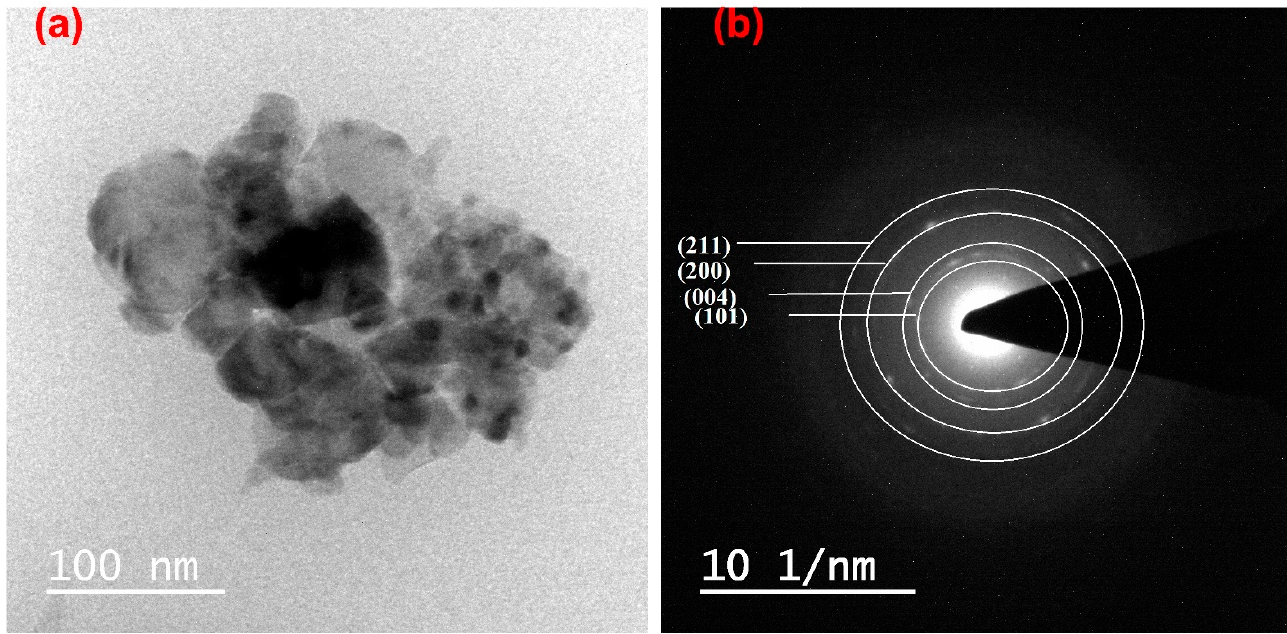
Figure 5. TEM image and SAED pattern ( a , b ) of AC/TiO 2 nanoparticles.